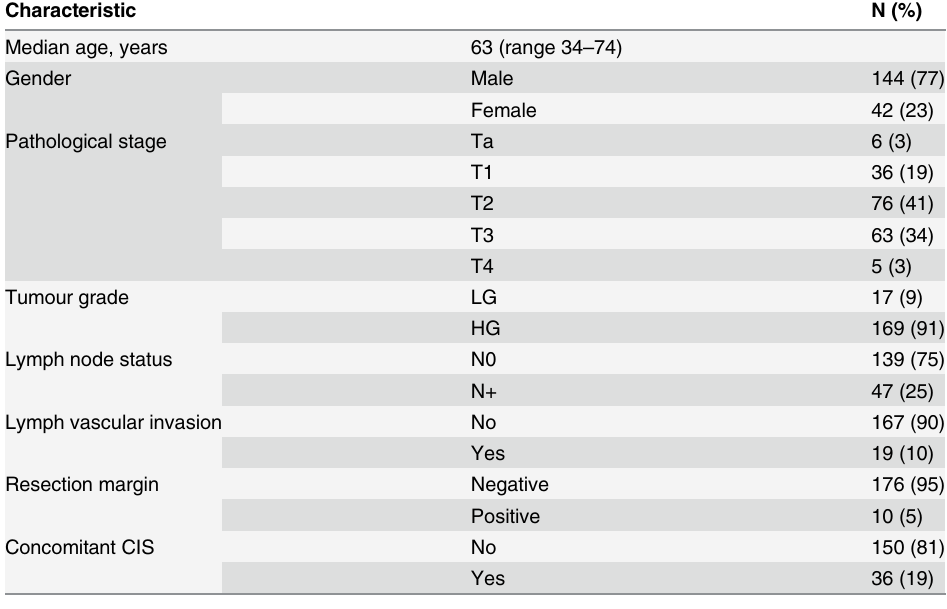
Table 1. Patient characteristics (n =